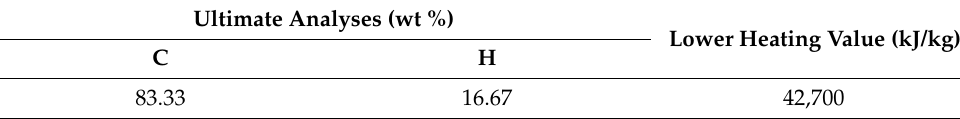
Table 3. Ultimate analyses of light